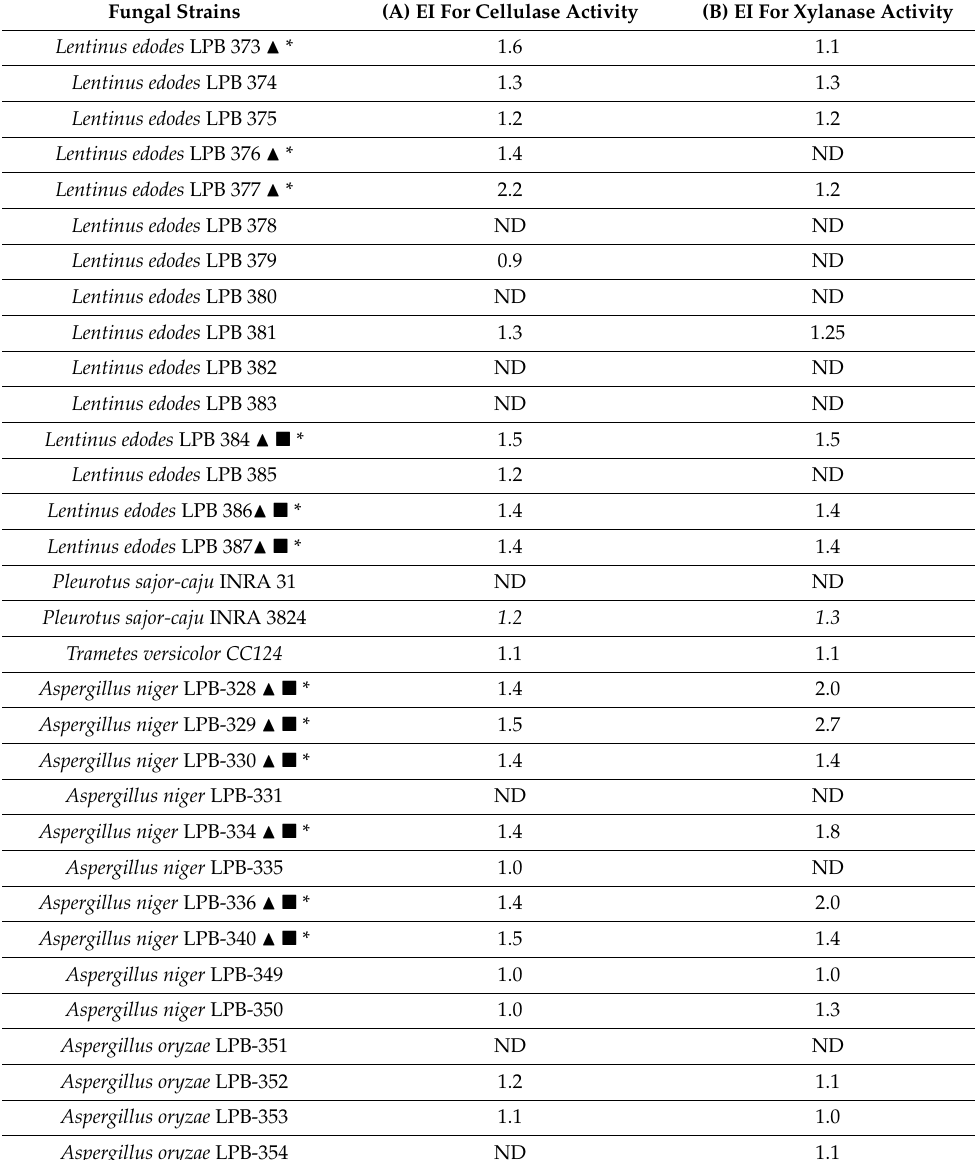
Table 1. Detection of cellulolytic (A) and xylanolytic (B) enzyme activities on solid medium by 32 fungal strains belonging to DEBB